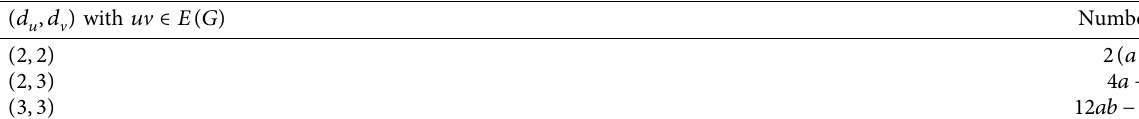
Table 6: The edge partition of T 1 [ a,b ]